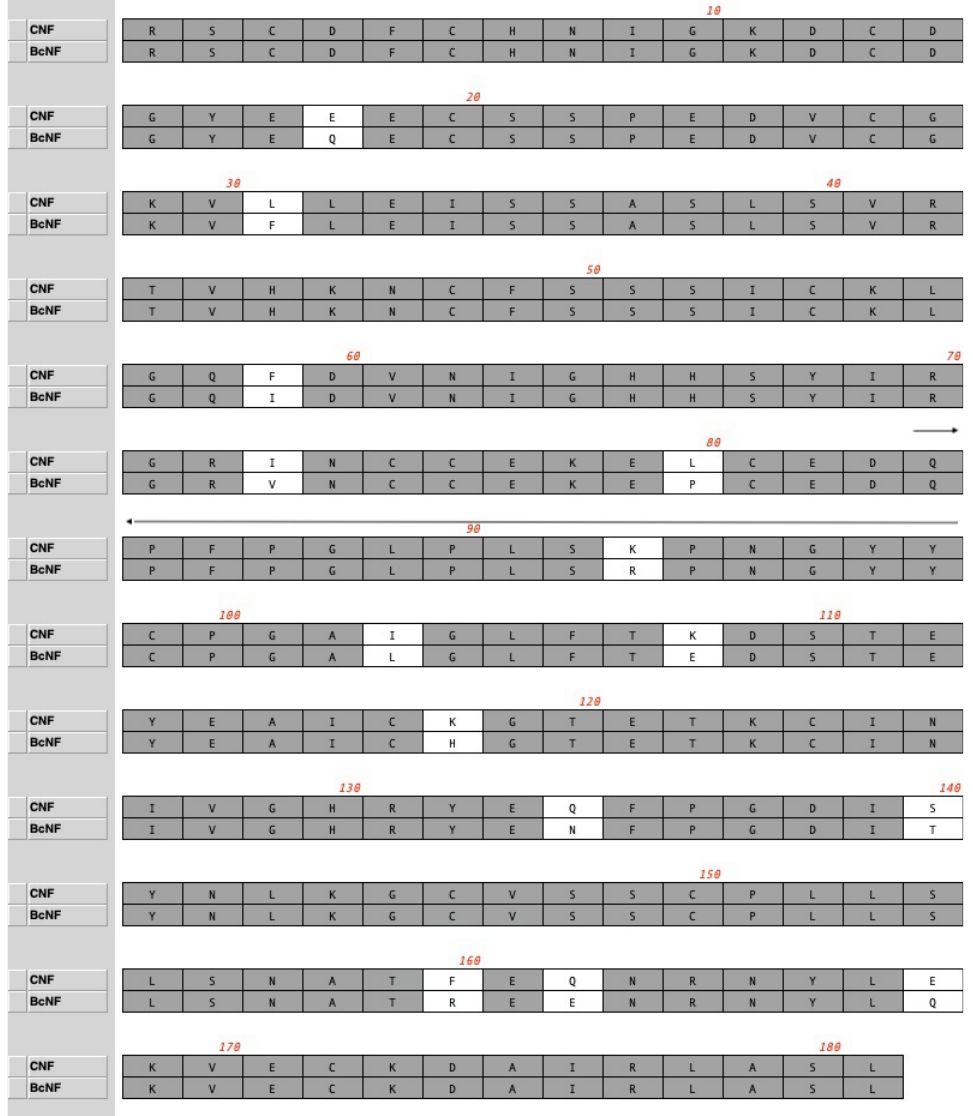
Figure 7. Alignment of the deduced primary structure of BcNF (sbγPLI from B. constrictor ) and CNF (sbγPLI from C. d. terrificus ). Identical amino acids are in grey background. Amino acid substitutions are in white background. The decapentapeptide Q 84 PFPGLPLSRPNGYY 98 is indicated by a continuous black arrow above the numbering